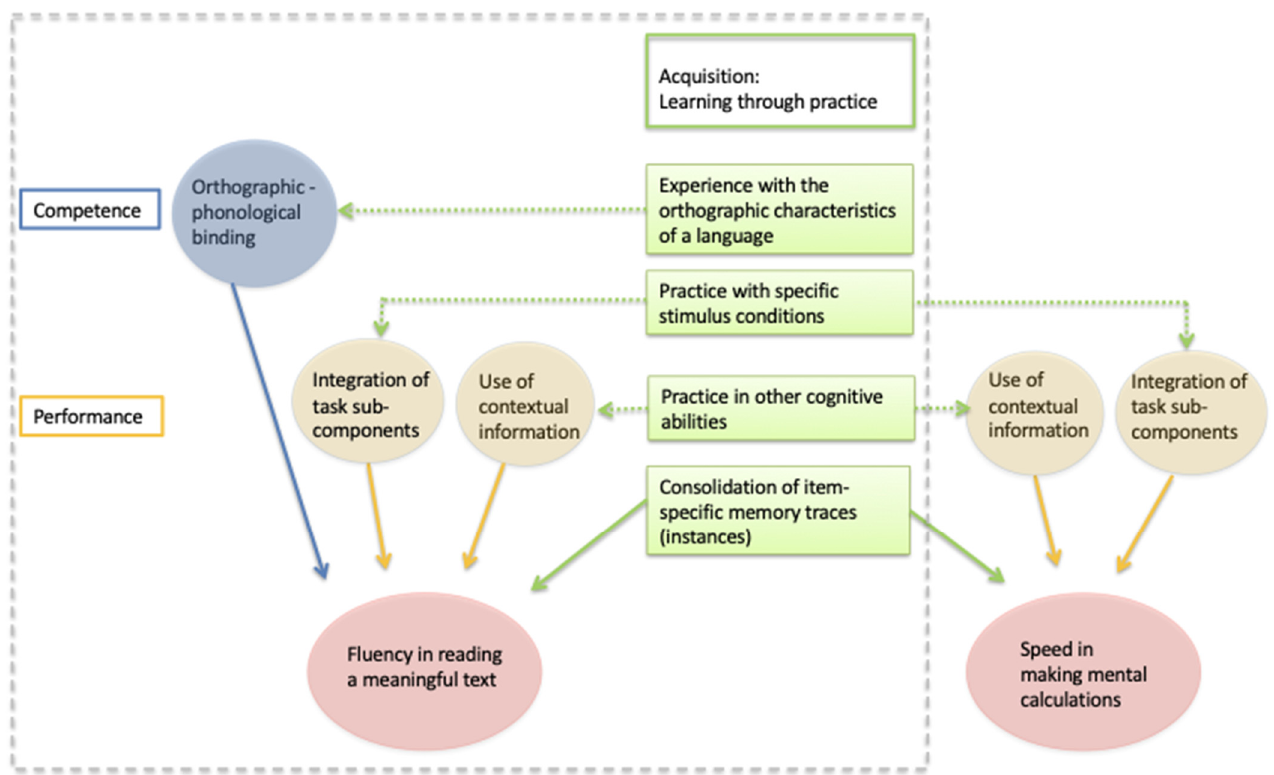
Figure 1. A multi-level model of the fluency in reading a meaningful text (see area within the grey dotted rectangle). The model envisages the separate influence of competence, performance, and acquisition. The figure especially focuses on the analysis of the acquisition level, i.e., the different ways of learning by practice (illustrated by four green boxes). The acquisition of reading competence is hypothesized in terms of orthographic–phonological binding derived from prolonged experience with orthographic material (top box). Two boxes report two examples of how practice may influence the performance level in reading (integration of task sub-components and use of contextual information). The bottom box reports the influence on reading behavior directly through the recall of item-specific memory traces (instances), favoring reading automatization. The right portion of the figure shows some of the connections of the acquisition boxes with a behavior different from reading (speed in making mental calculation). Note that some performance factors may exert similar influences on more than one behavior (although there may also be performance factors with different influences on different behaviors; see main text for further discussion of this point). Furthermore, it is expected that the recall of item-specific memory traces may directly boost performance across different behaviors. Finally, no connection is envisaged between the reading competence and the performance in making mental calculations.